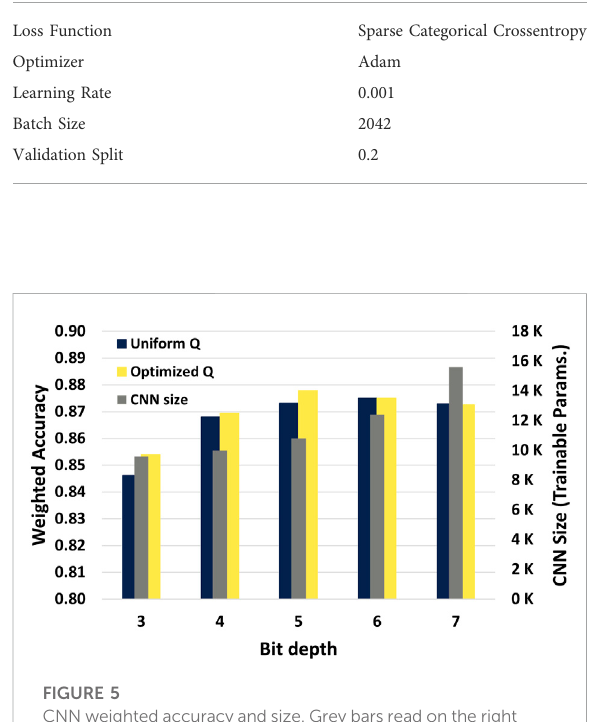
TABLE 1 CNN training Con fi gurations.